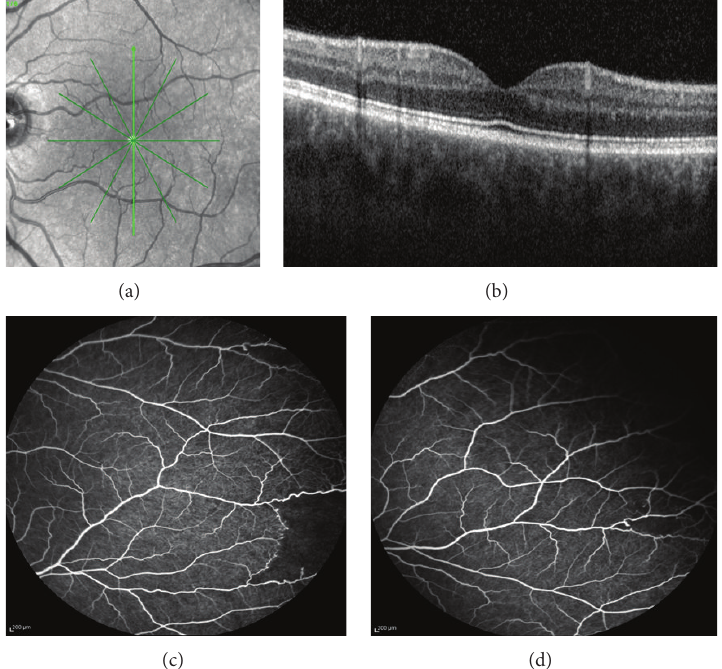
Figure 2: (a, b) Infrared fundus photo and optical coherence tomography in the left eye, totally normal; (c, d) fluorescein angiography, showing small ischemic areas at the temporal periphery of the left